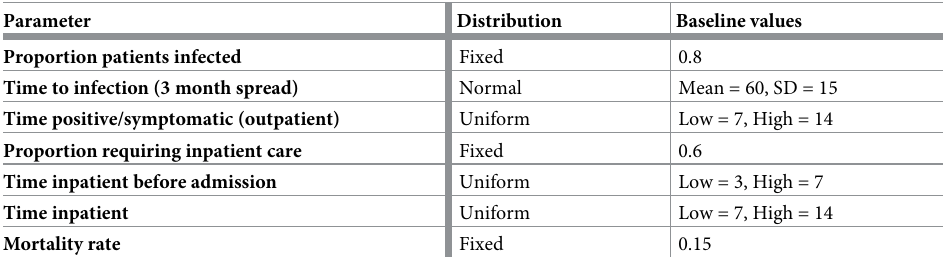
Table 1. Baseline model